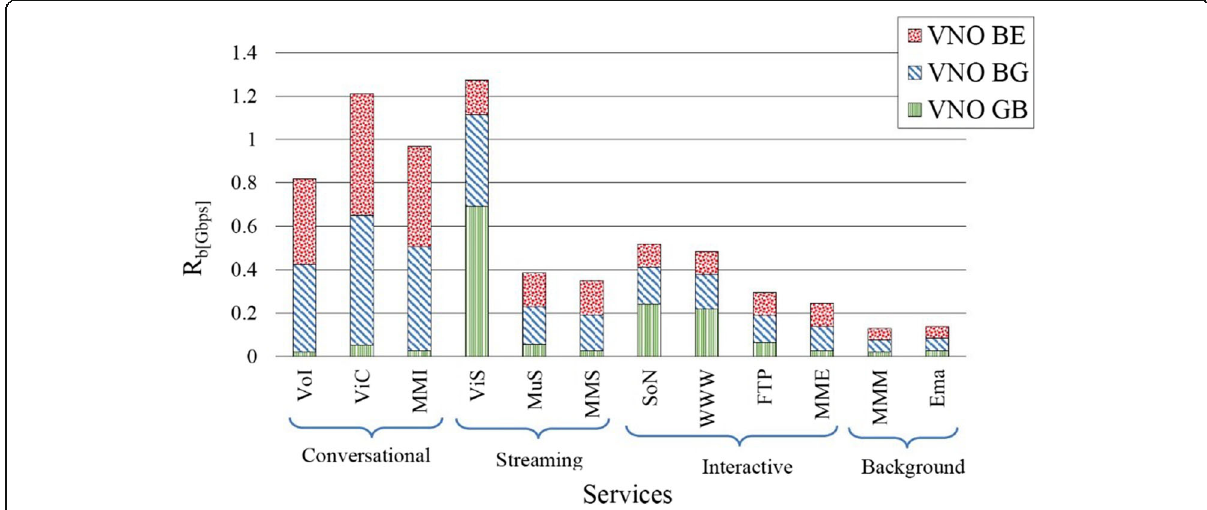
Fig. 5 Data rate allocated to different services of the VNOs